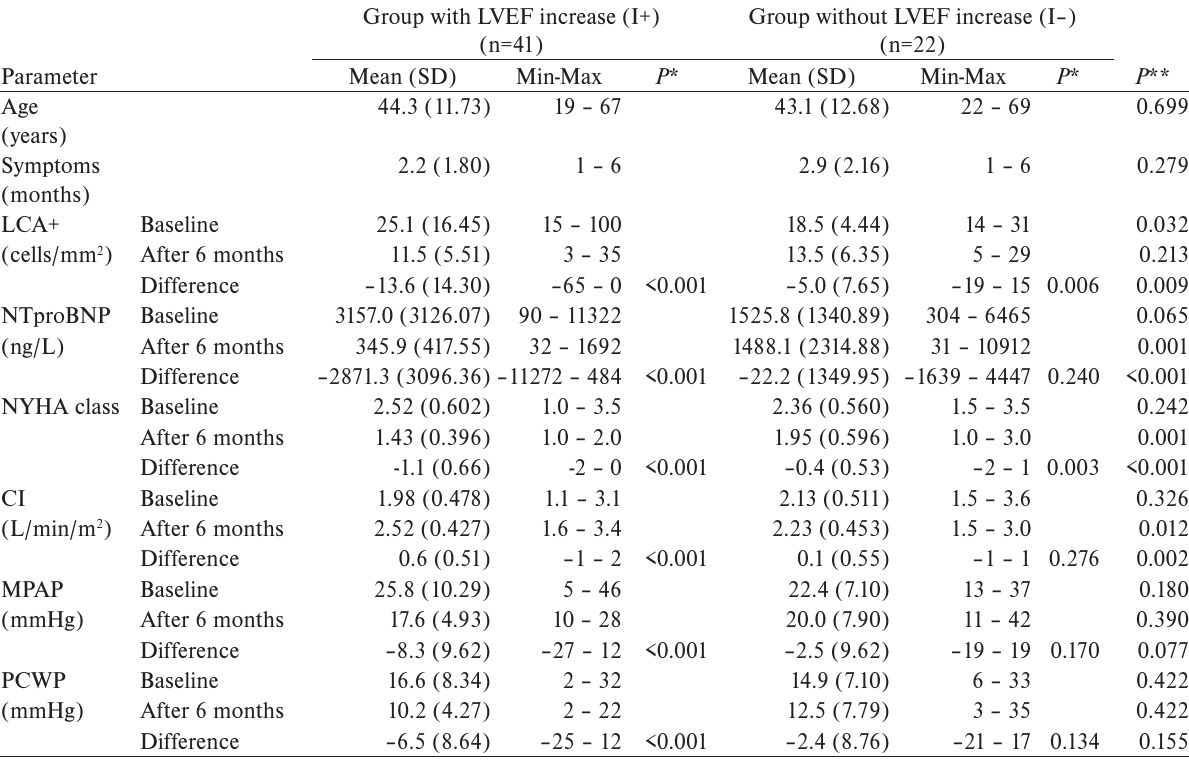
Table 1. Comparison of the groups with and without LVEF